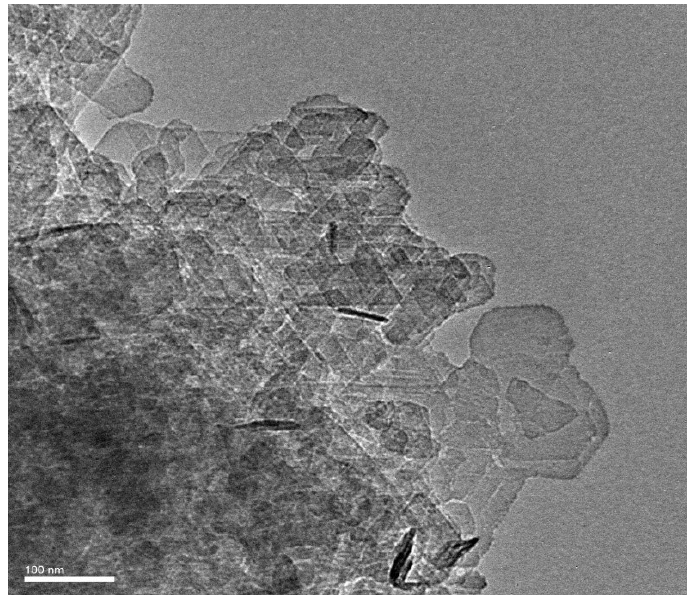
Figure 2. Scanning electron micrograph/image of bentonite clay particles (SEM analysis data).